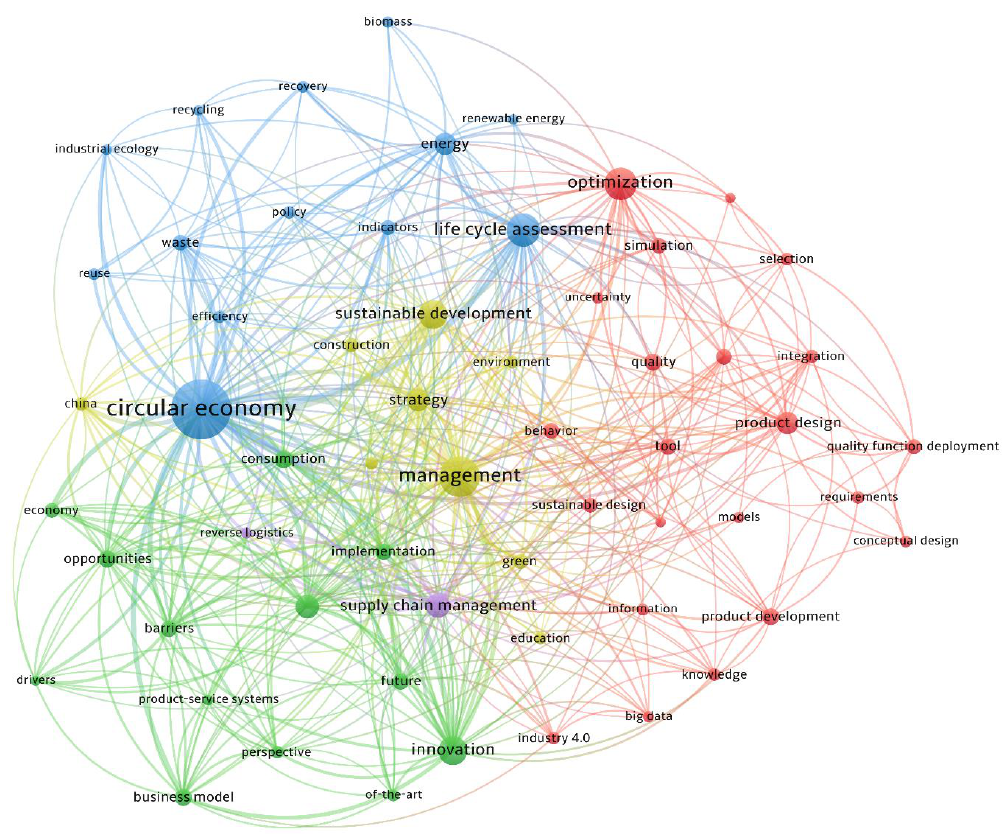
Figure 5. Network map of co-occurrence analysis of author keywords with 50 occurrences or more.